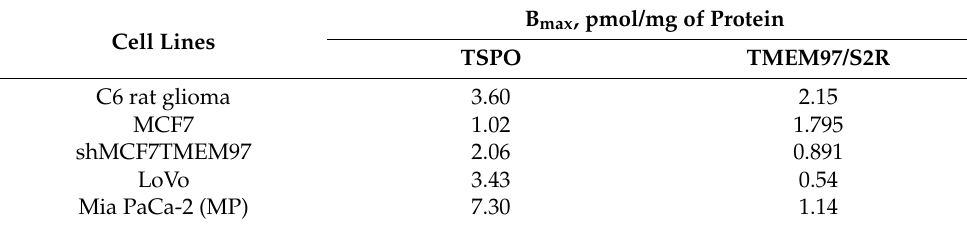
Table 1. TSPO and Sigma-2 receptors expression in different cell lines. Cell